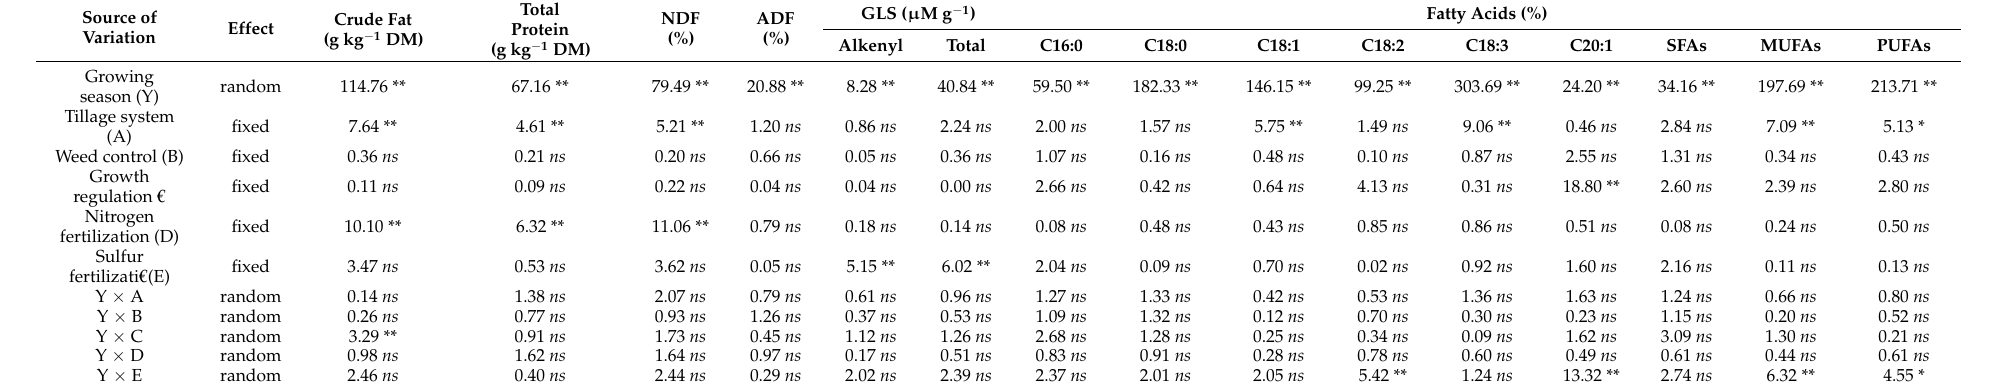
Table 2. F -test statistics in ANOVA of seed quality in WOSR